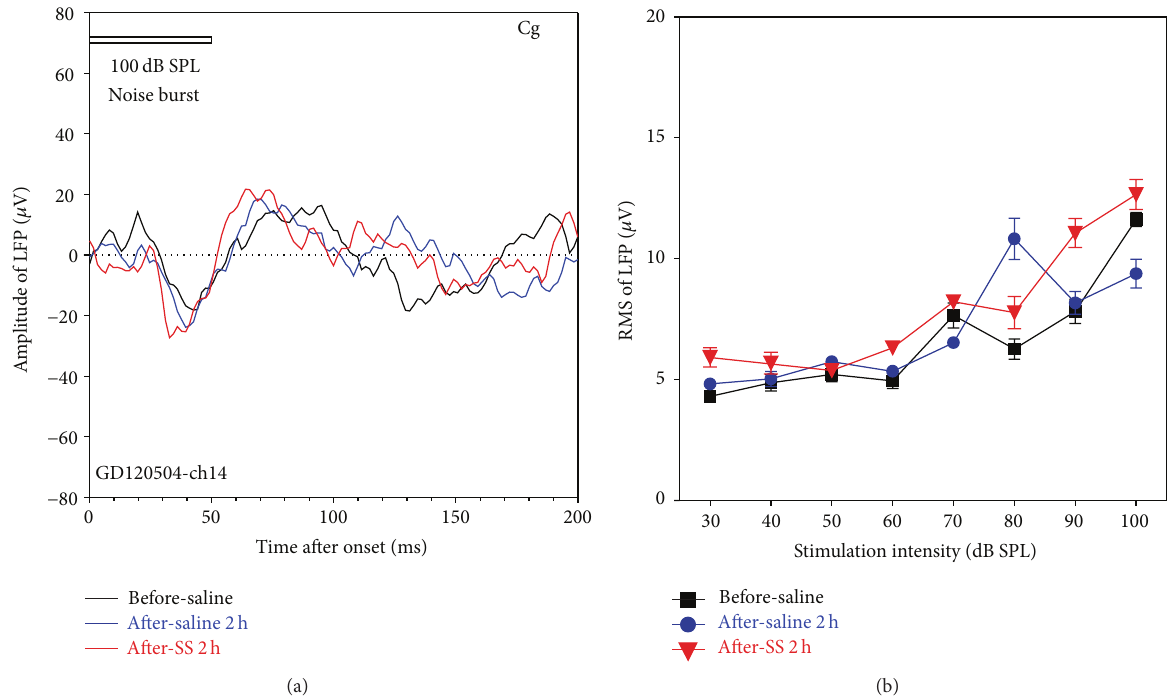
Figure 9: The effect of SS on noise-burst-evoked LFP elicited from electrodes in the cingulate cortex. (a) An example of LFP at 100 dB SPL recoded before treatment (black), after saline (blue), and after SS (red), showing no change during treatment. (b) Mean RMSs of LFP ( 𝑛 = 16 ) in a time window of 100ms as a function of stimulation level, showing no significant change of the mean LFP. Stimulation: 50 ms noise burst; treatment: SS (250 mg/kg, i.p.). The vertical bars are